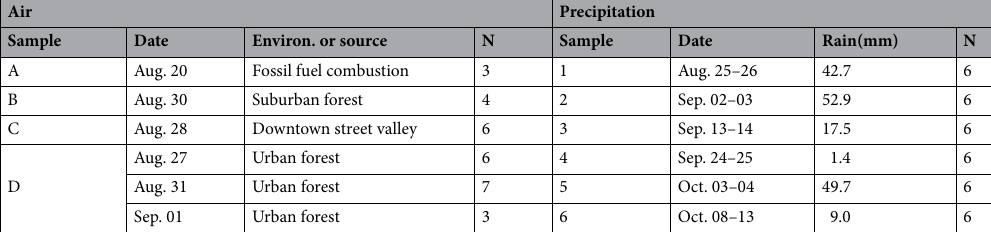
Table 1. Tropospheric environments and sources analyzed in this study. Sample A and B stand for the source of anthropogenic air pollution and primary biogenic emission, respectively, all the rest samples for the tropospheric environments. N indicates the number of samples collected and